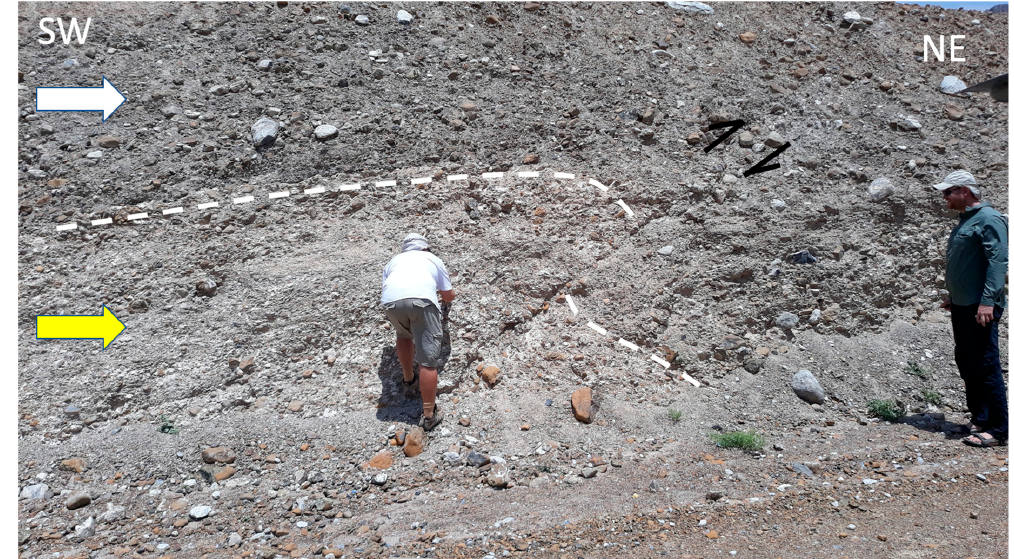
Figure 4. Upper unconsolidated samples (white arrow), and lower consolidated layer (yellow arrow) in fault 6. The displacement is ~1 m. Note the erosional contact between the two conglomerates (white dashed line). Also note drag folding!